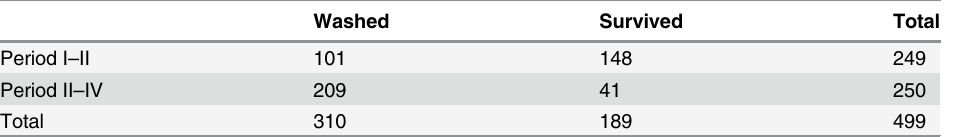
Table 6. Contingency table of the number of washed-out and surviving individuals during the increas- ing and decreasing periods. Washed Survived Total 101 148 249 41 250